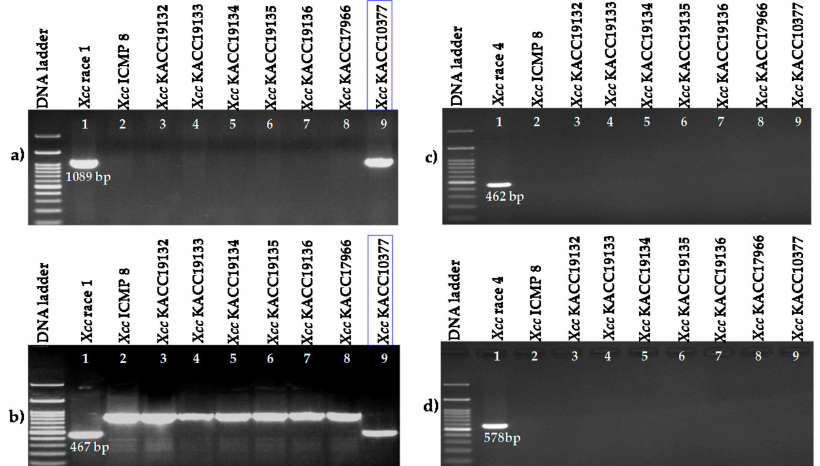
Figure 7. PCR amplification of race-unknown strains of X. campestris pv. campestris for race determination with two race 1-specifc markers: ( a ) Xcc_47R1 and ( b ) Xcc_85R1; Lane1: HRIW-3811 ( Xcc race 1 control); and with two race 4-specific markers ( c ) Xcc1_46R4 and ( d ) Xcc2_46R4 Lane1: HRIW-1279A ( Xcc race 4